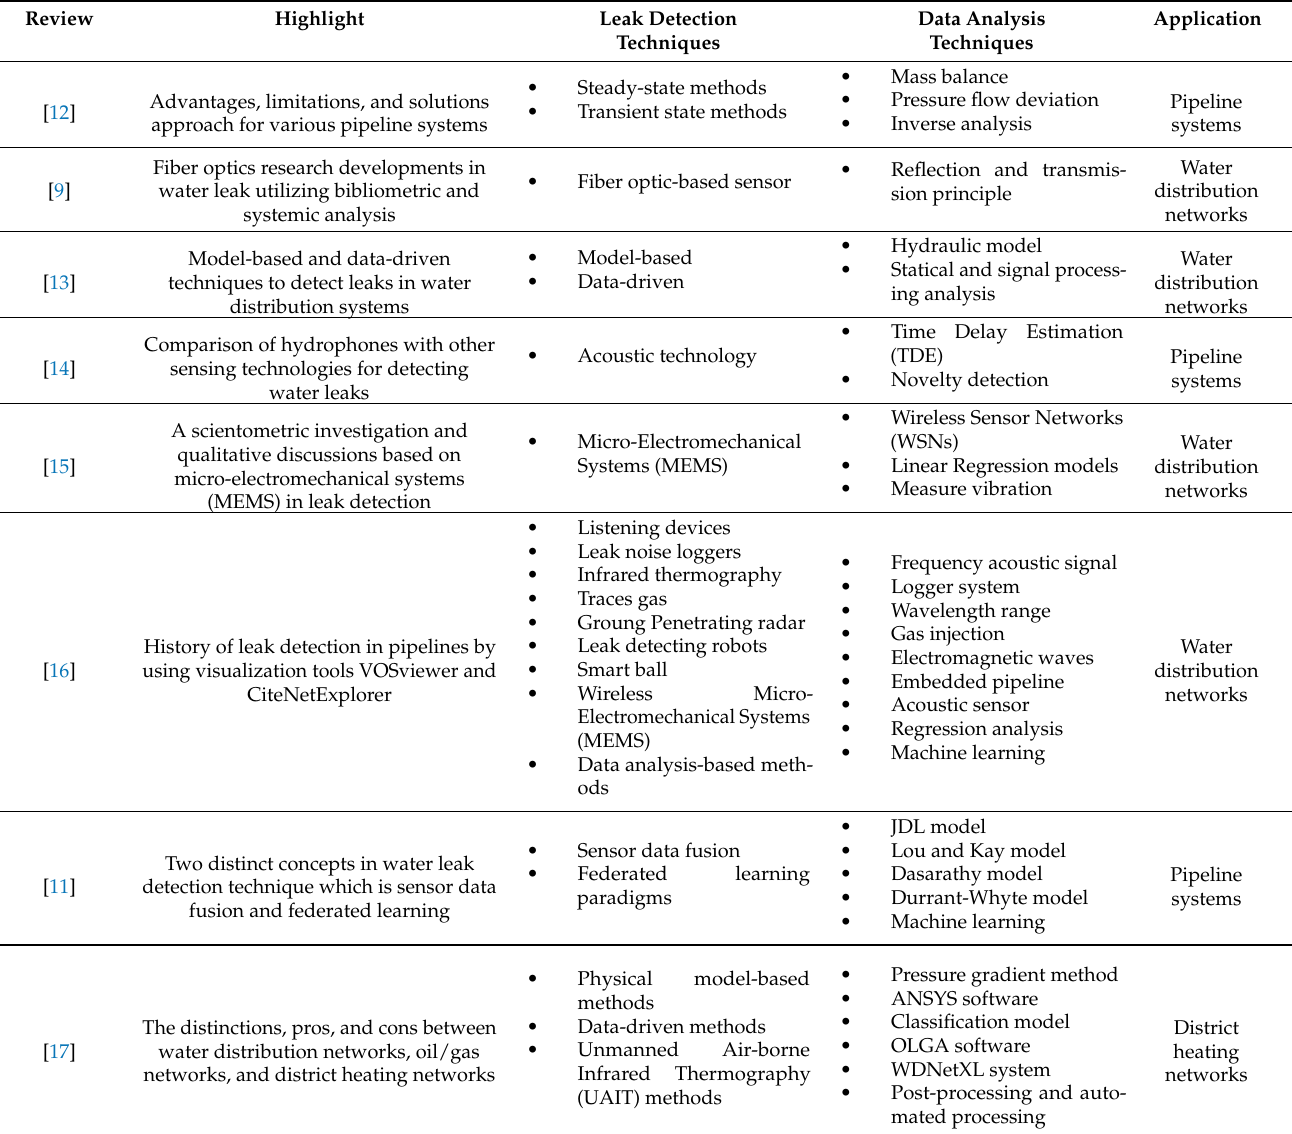
Table 1. Summary of the previous review work on water leak detection